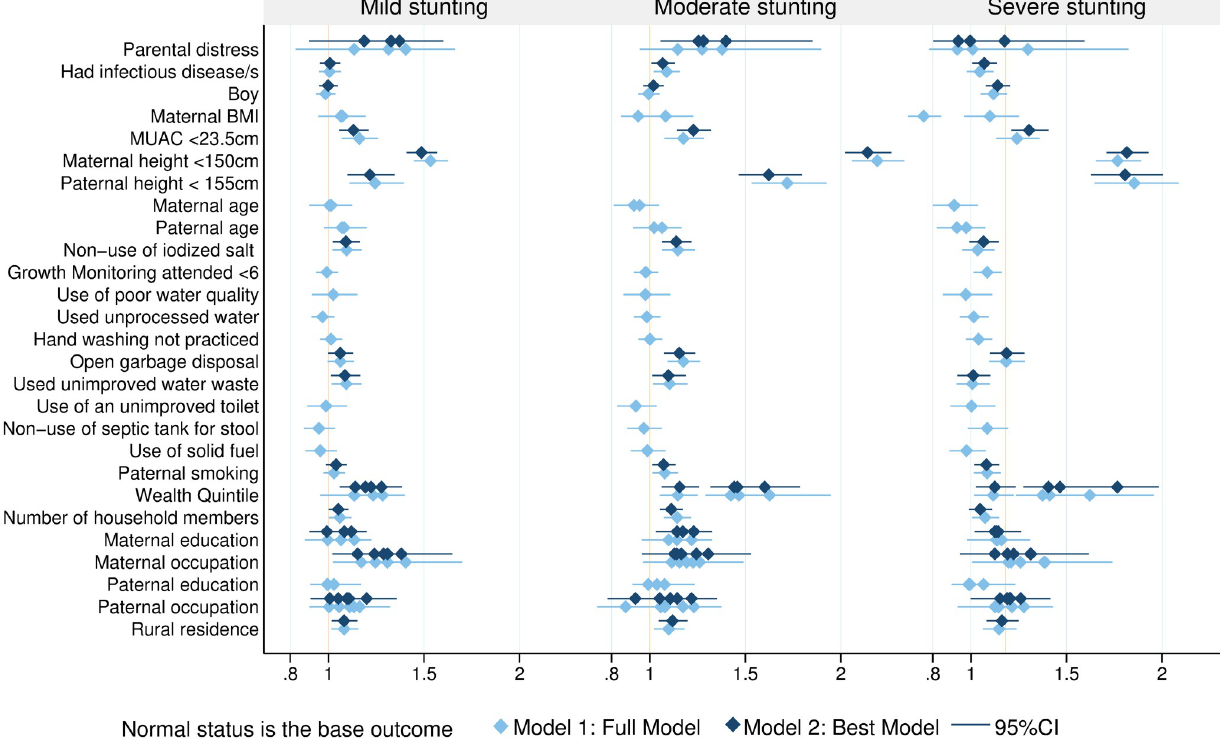
Fig 4. The relative risk ratio of distress of parents and other factors for stunting of children age 6–59 months. Multiple point estimates shown for some categories indicate the risks and 95% confidence intervals (CI) for the specific subcategories in comparison to the reference group, as shown in Table 2.